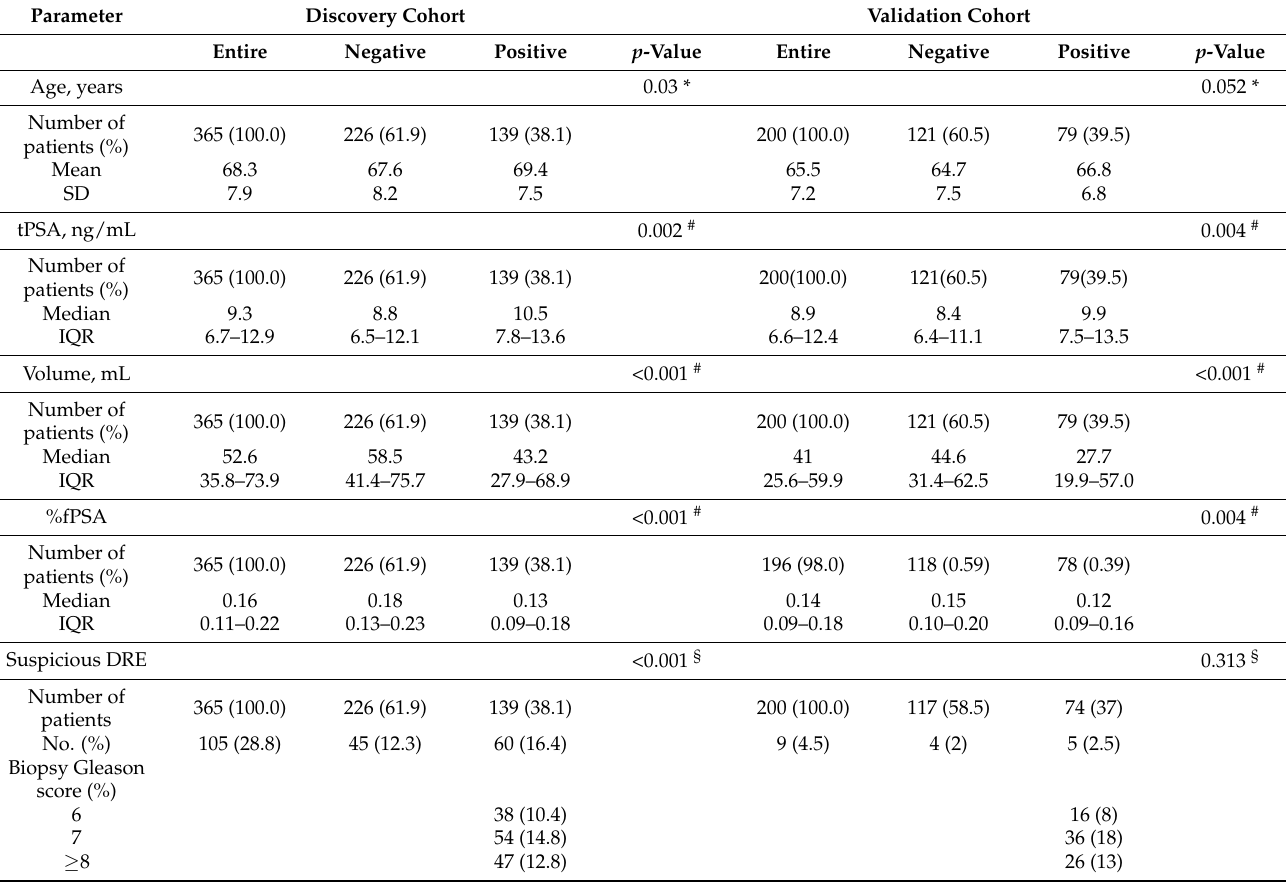
Table 1. Demographics and clinical characteristics of